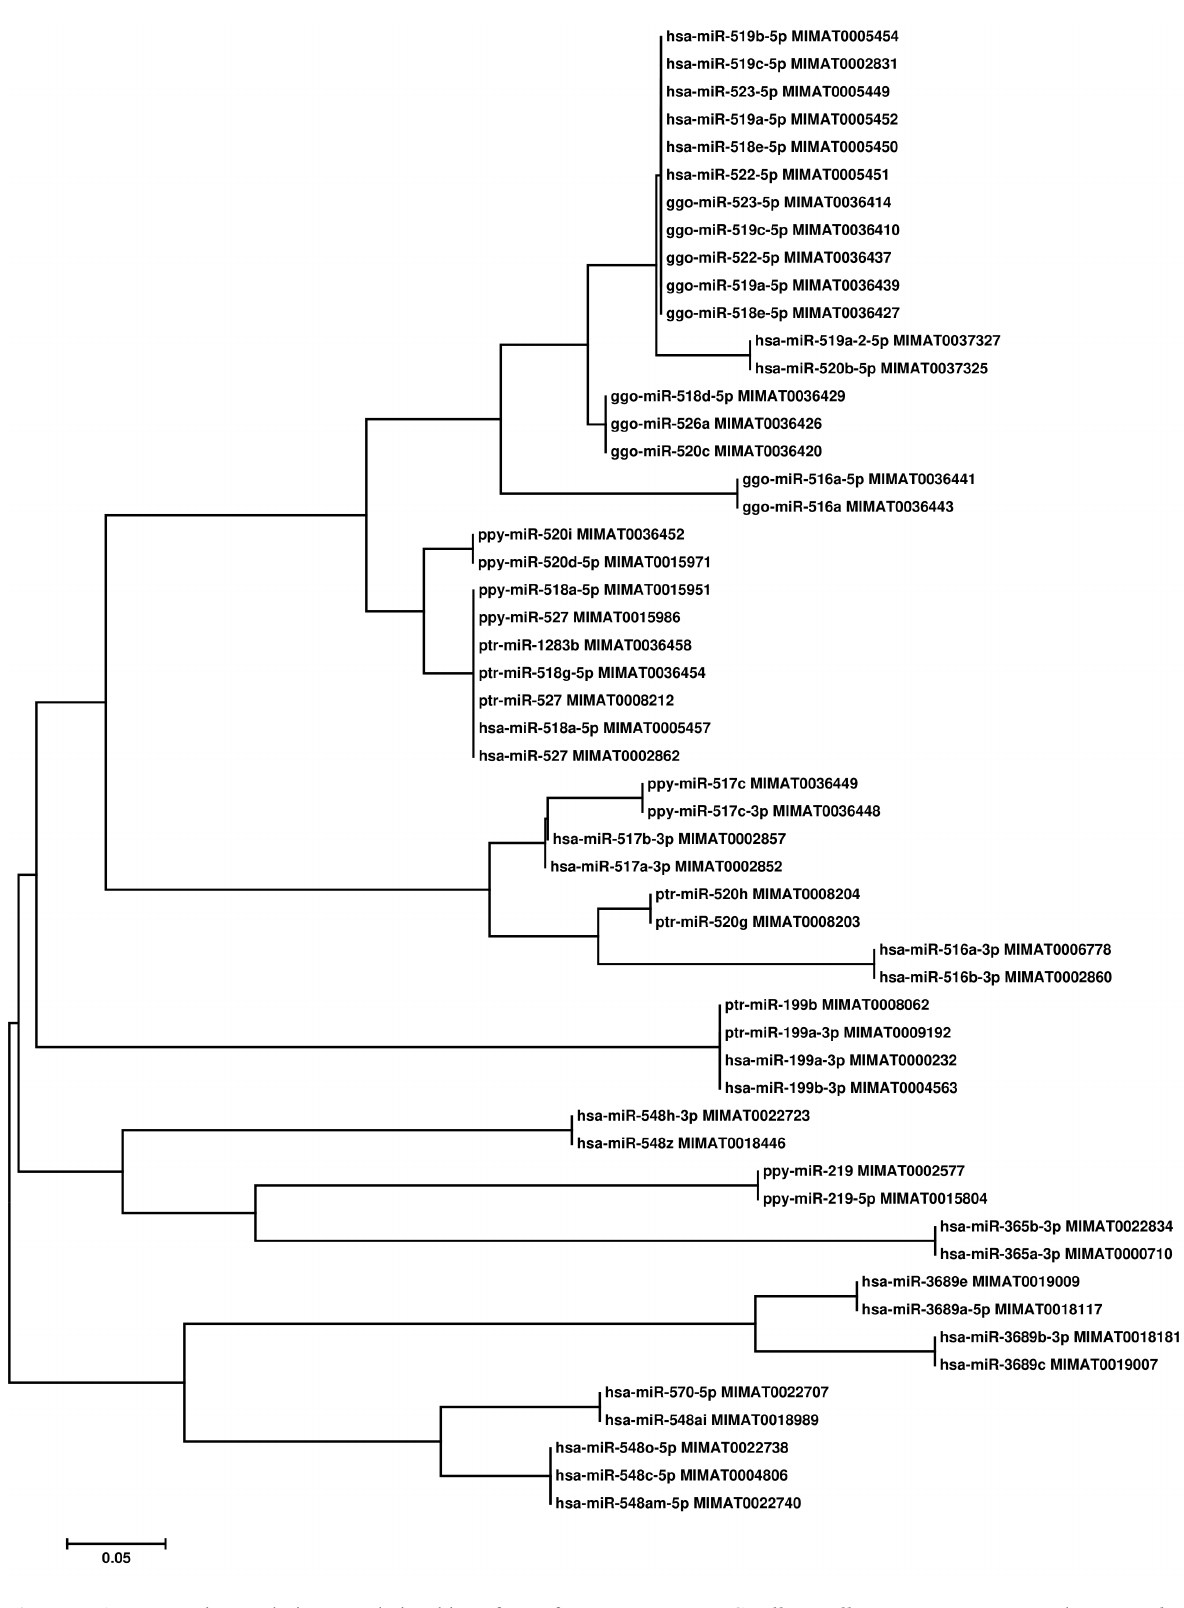
Figure 5. A comparative evolutionary relationships of taxa for Homo sapiens , Gorilla gorilla , Pongo pygmaeus and Pan troglo- dytes. The analysis involved 54 nucleotide